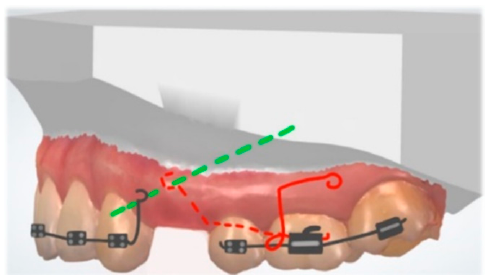
Figure 11. Statically determinate retraction system for space closure. Cantilever (red) is activated for anterior segment retraction (green: line of action).